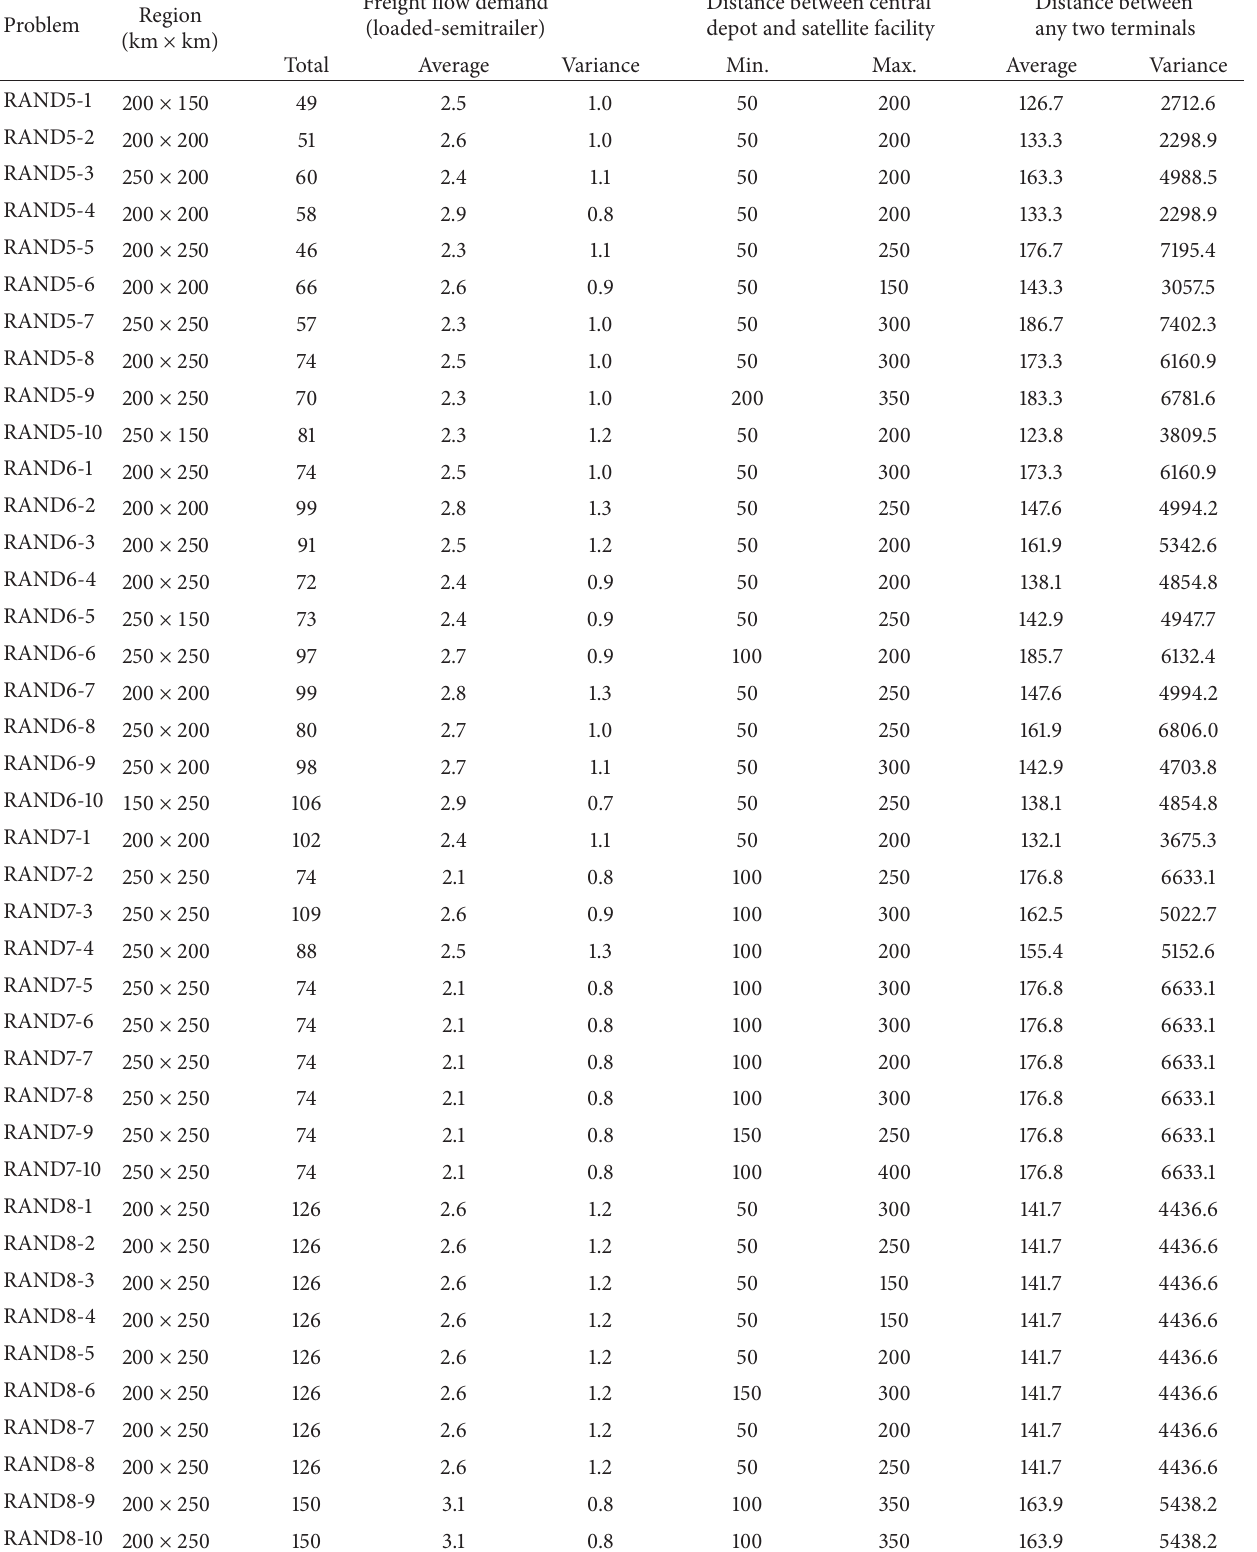
Table 1: Basic characteristics of the 40 test